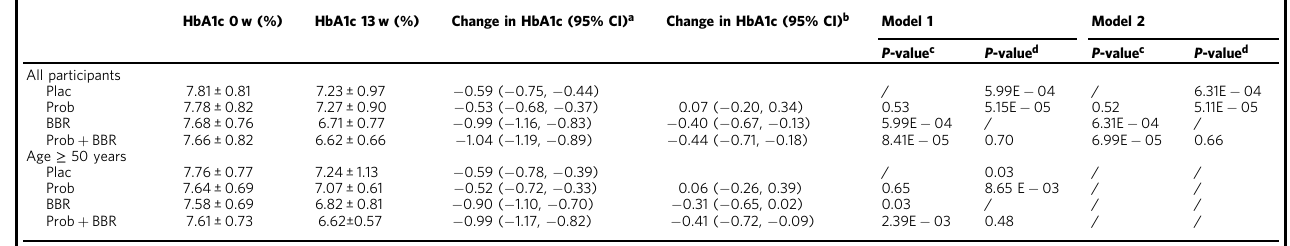
Table 2 Primary outcomes in all and older participants (age ≥ 50